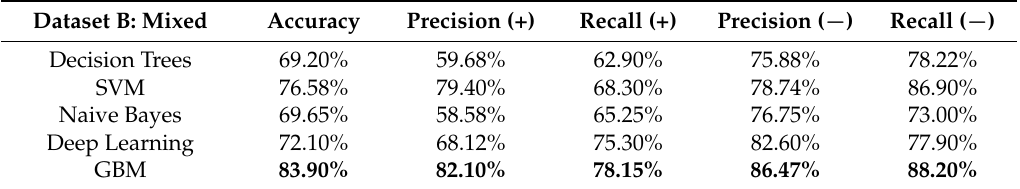
Table 6. Performance of GBM against other benchmarking methods for Dataset B: mixed.